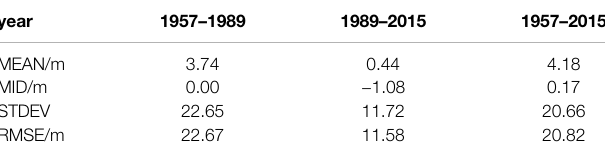
TABLE 1 | Errors of the different DEMs in 1957, 1989, and